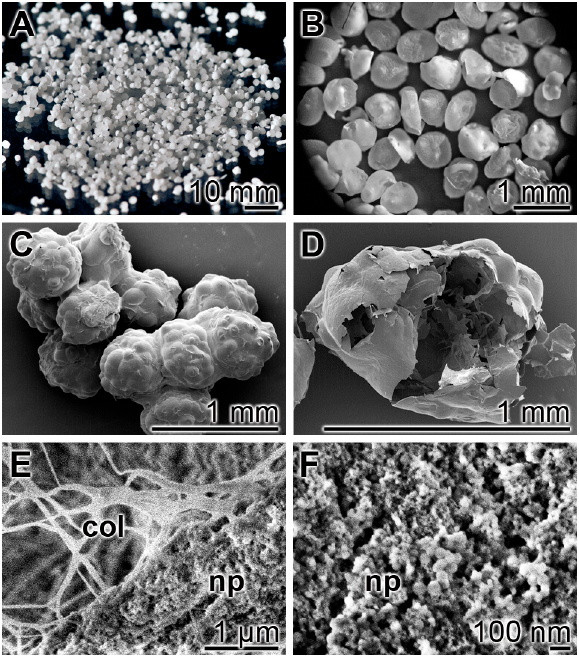
Figure 4. Electron microscopic images of the host–guest “col/polyP-MPs”; ( A ) to ( D ): Reflection electron microscope (REM) and ( E ) and ( F ): SEM. ( A ) and ( B ) At a lower magnification (REM) the particles appear as globular to disc-like particles. ( C ) The intact particles have on their surfaces ball-like protrusions which ( D ) proved to be gas bubbles in broken particles. ( E ) and ( F ) At SEM magnification it can be identified that the scaffold material is built of a collagen (col) fiber framework around which nanoparticles (NPs), within the microparticles, are arranged. ( F ) At the higher magnification it can be resolved that the polyP nanoparticles, formed at the collagen scaffold, have a homogeneous morphology with a diameter of ≈ 30 nm.